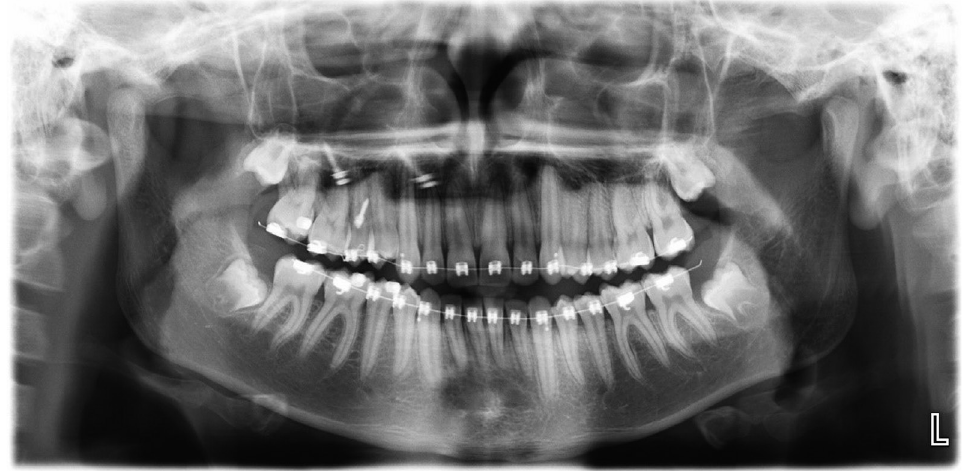
Figure 11. Post-treatment panoramic